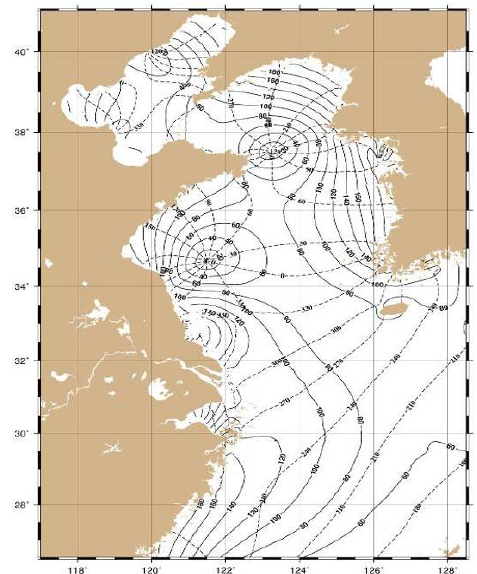
Figure.3 Co-amplitude line and Co-pulse lag line of M2